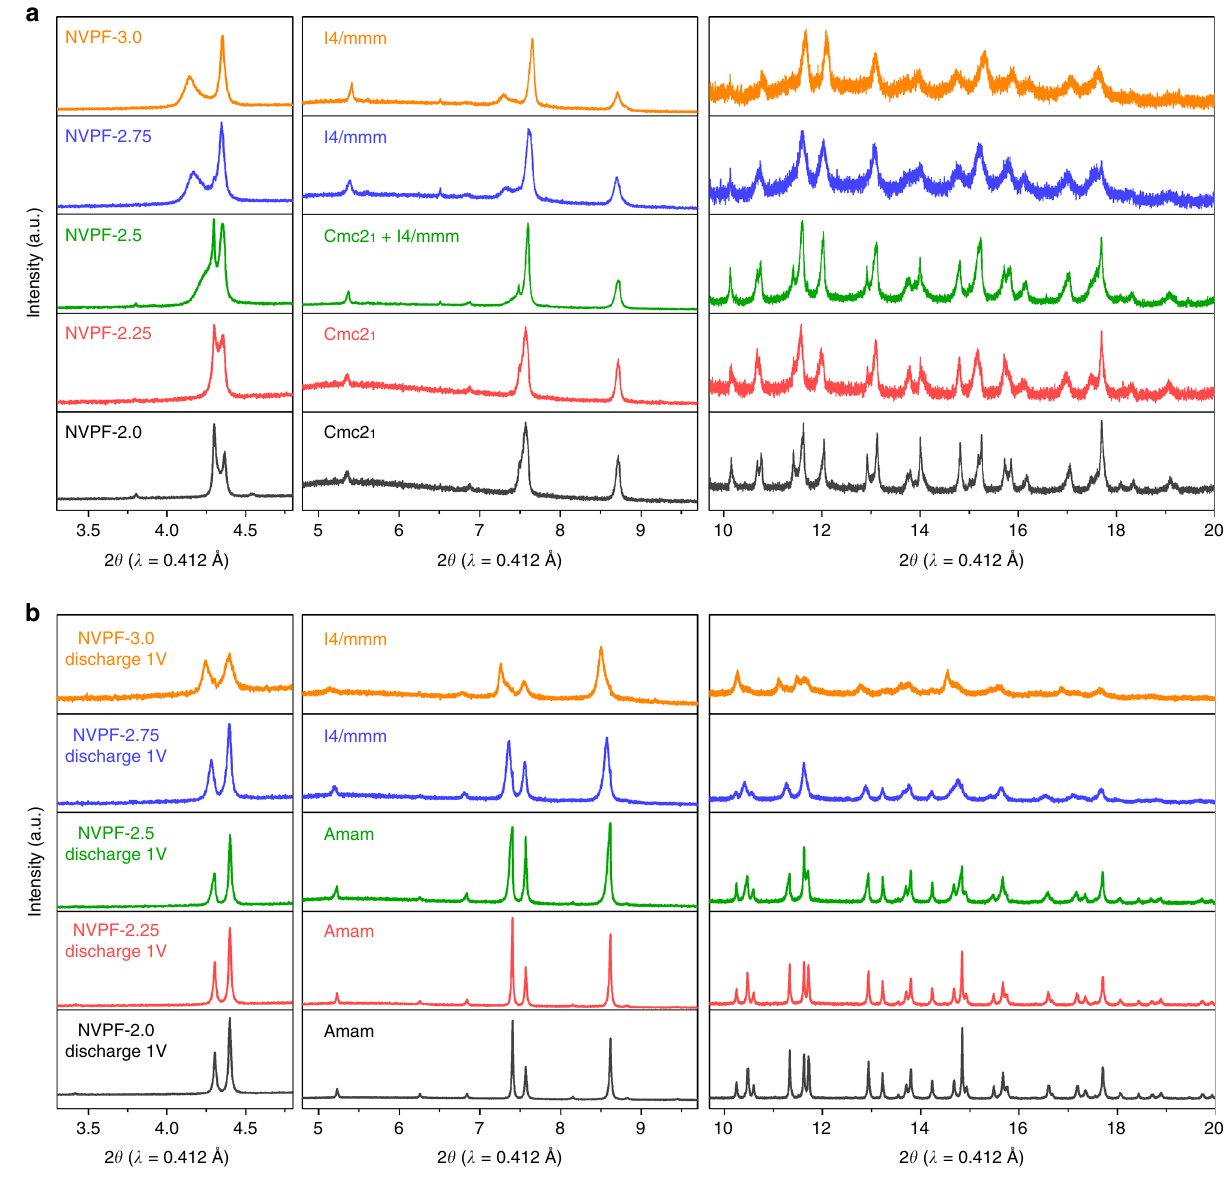
Fig. 4 Structural evolutions during three sodium ions extraction/insertion in NVPF. a Synchrotron X-ray diffraction patterns of the charged samples with different amounts of Na extracted (NVPF-2.0, NVPF-2.25, NVPF-2.5, NVPF-2.75, and NVPF-3.0). b The other set of samples further discharged down to